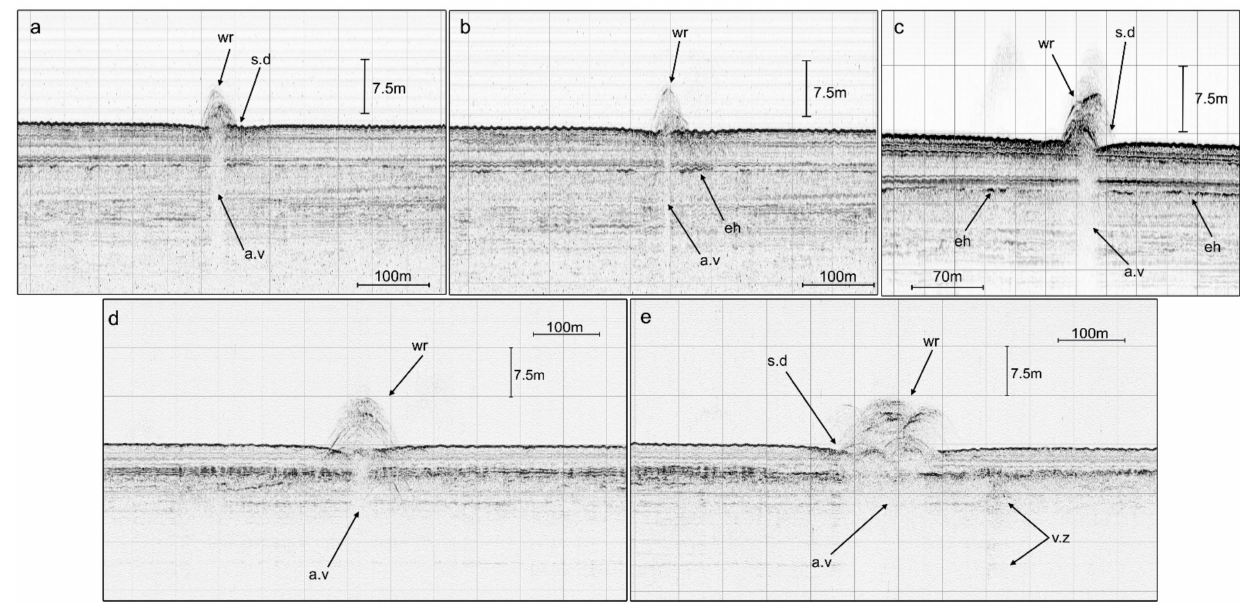
Figure 11. ( a , b ) Profile at 3.5 kHz and ( c ) chirp profile across the “old iron” wreck and ( d , e ) chirp profiles of “pump house” wreck showing the multiple hyperbolic echoes due to the existence of the wrecks (wr) and the seabed depressions (s.d) around them (a.v: acoustic void area, eh: enhanced reflectors, v.z: vertical zone of acoustic